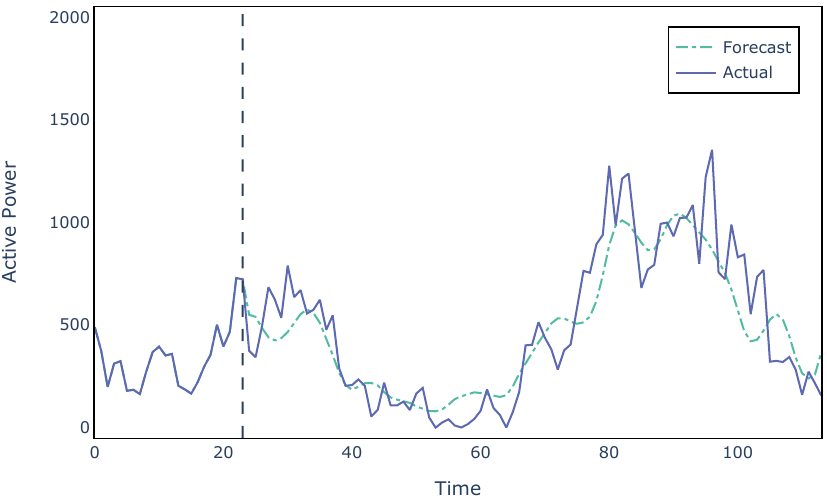
Figure 13. Example of wind power forecasts produced by the spatio-temporal neural network for turbine R80721. The x-axis ranges from 0 to 114 and includes the observed history of measurements (0–23) and the 90 forecast lead times (24–113), separated by a vertical dashed line in correspondence with the forecast